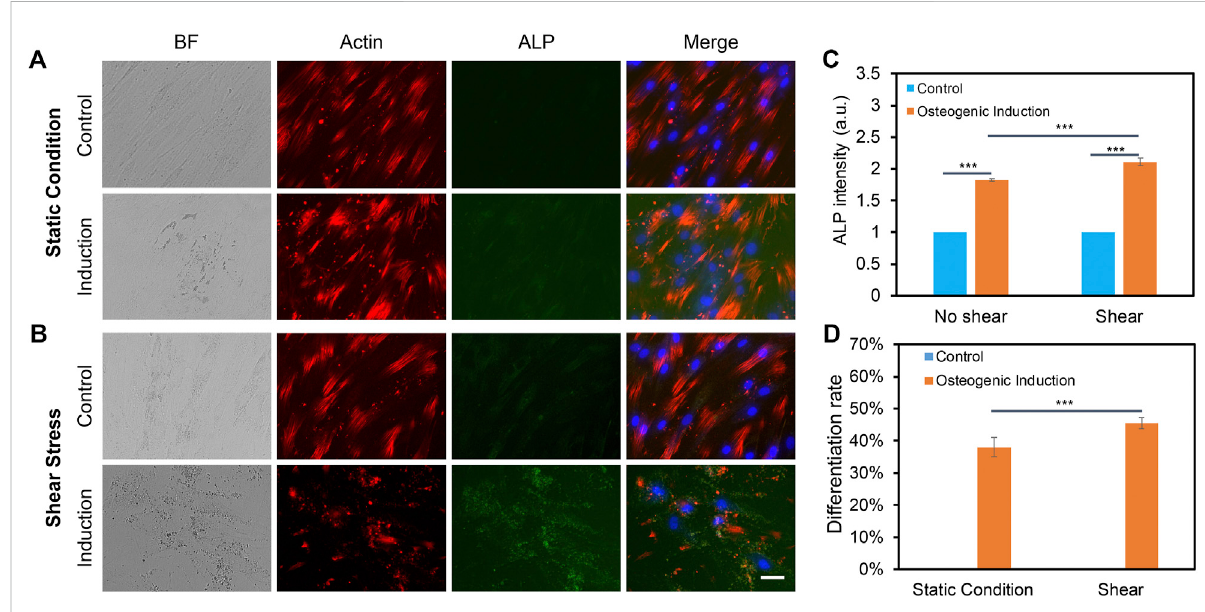
FIGURE 4 Orbital shear stress enhanced hMSCs osteogenic differentiation. Representative bright fi eld and fl uorescence images of hMSCs cultured with basal culture medium and osteogenic induction medium for 5 days under static condition (A) , and exposed to shear stress (B) , respectively. hMSCs that were exposed to orbital shear stress for 5 days with 6 h per day. Samples were stained with ALP (green; by ALP live stain), F-actin (red; by phalloidin), and nuclei (blue; by hoechst 33342), respectively. Scale bar: 100 μ m. (C) Fluorescence intensity of ALP activity of hMSCs with and without shear stress after 5 days of osteogenic induction compared to control group. (D) Osteogenic differentiation percentage with and without shear stress. Data represent over 100 cells in each group and are expressed as mean± s.e.m. ( n = 6, ***, p < 0.001, **, p <